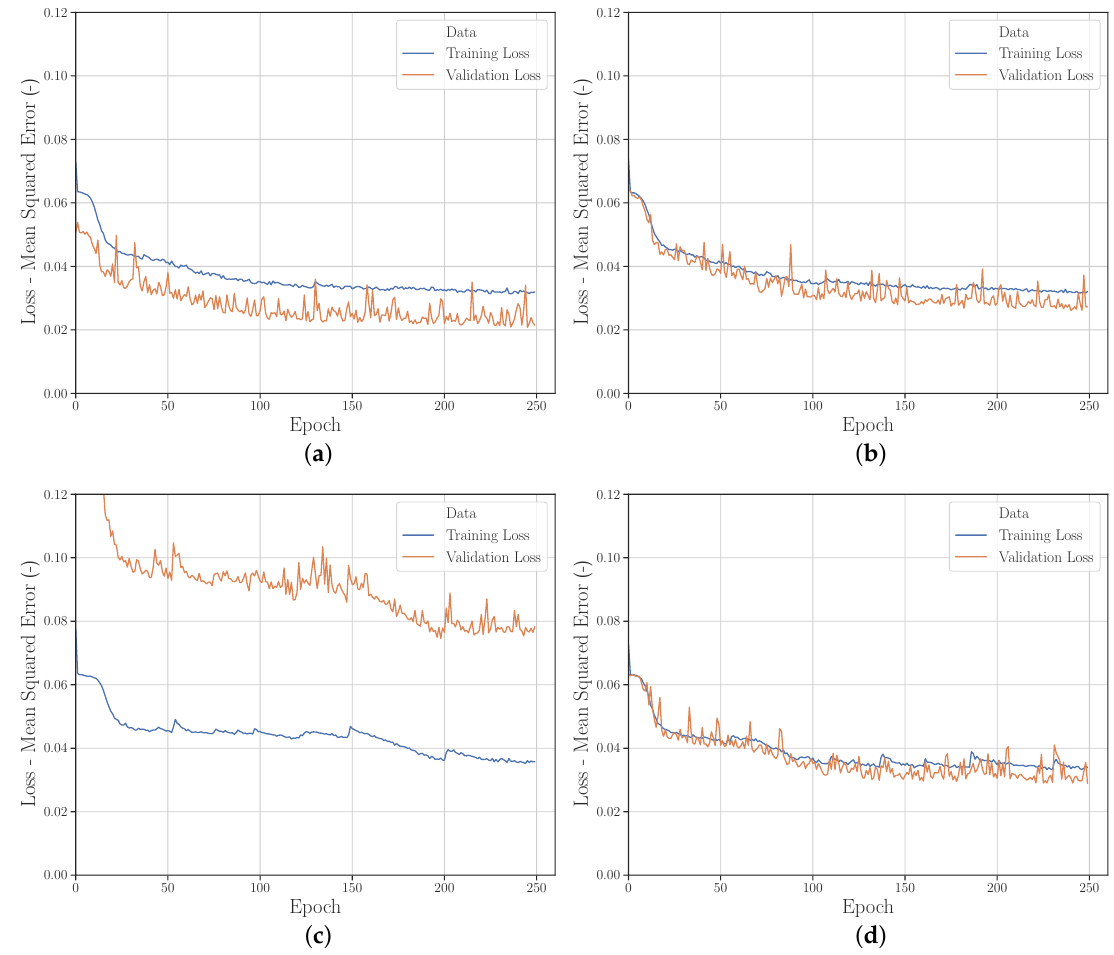
Figure 11. Learning curves for different variations of parameter ranges and training set/validation set ratio; ( a ) Run_2 , ( b ) Run_15 , ( c ) Run_17 and ( d ) Run_20